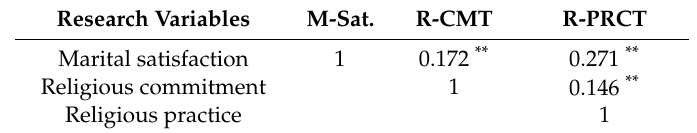
Table 5. The correlations between marital satisfaction and religiosity dimensions.